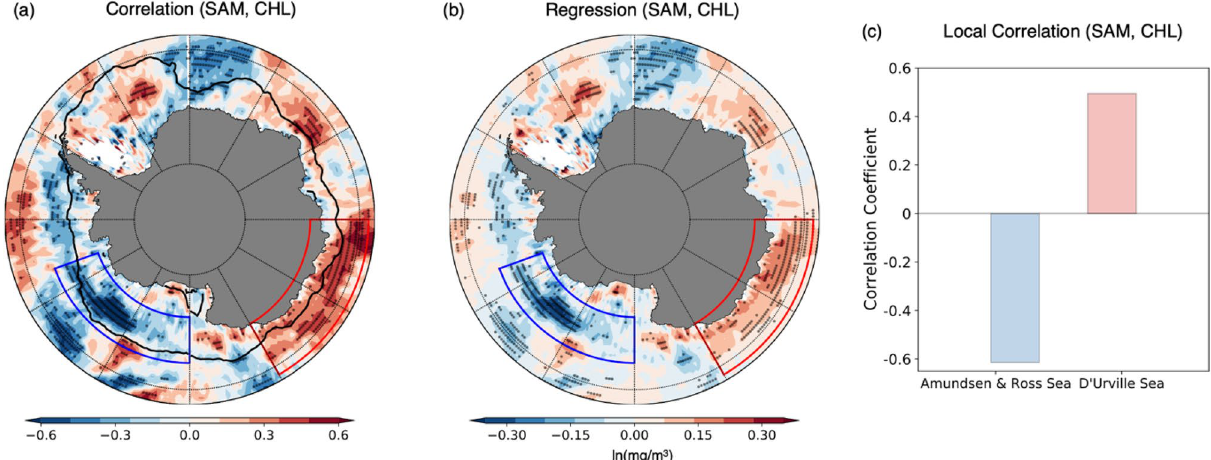
Figure 1. ( a ) Correlation and ( b ) regression map of the SAM index and chlorophyll concentration. The natural mg / m − 3 log of the chlorophyll concentration [ ln ] was used to estimate the correlation and regression. The thick solid line, which is the 15%-sea-ice concentration line, represents the climatology of sea ice extent in the (cid:30) (cid:31) austral summer for 1998–2019 period, and the 95% significant correlation ( p value < 0.05) regions are expressed as black dots. White areas indicate the region where satellites have not observed chlorophyll for at least three years due to sea-ice cover or cloud. ( c ) The correlation coefficients between the SAM and natural log chlorophyll concentration that are spatially averaged over the western and eastern parts of the Southern Ocean are shown using blue and red boxes,